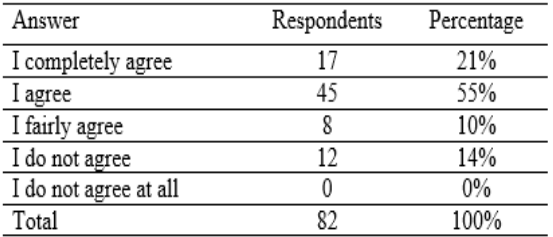
Table 6. Table of received answers to question number